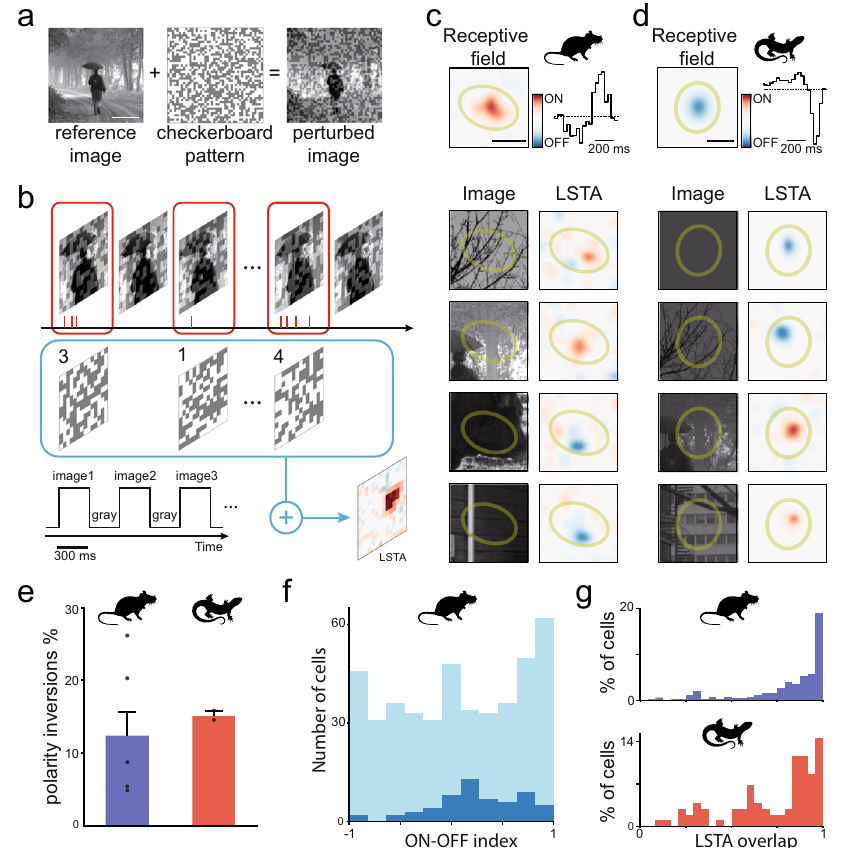
Fig.1|ON-OFFselectivitycanchangeinanaturalcontextforthesameganglion cell. a We added a random checkerboard pattern with low contrast on top of a natural image to obtain a perturbed image. Scale bar: 500 µ m. b We fl ashed a randomized sequence of perturbed and unperturbed images. All fl ashes lasted 300ms and were separated by 300ms of gray whose luminance was equal to the mean luminance of the images. To calculate the LSTA, we averaged the different perturbations, weightedby the number of spikes they evoked. c , d Two examples of LSTAs, for mouse (ON cell, c ) and axolotl (OFF cell, d ), measured for two example cells and different perturbed images. Top: the classical receptive fi eld with its spatial (left) and temporal (right) components. A green ellipse fi tted to the spatial component is shown in all the bottom panels as a reference for each cell. Bottom left: reference image; bottom right: corresponding LSTA. The fi rst two rowsLSTAsmatchtheclassicalpolarity,andthelasttworowsshowapolarity inversion. Scale bars: 200 µ m. e Percentage of ganglion cells showing both ON